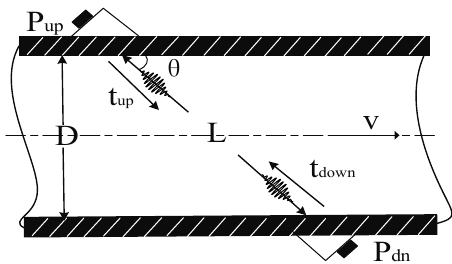
Figure 1. Schematic diagram of the principle of time-difference method.